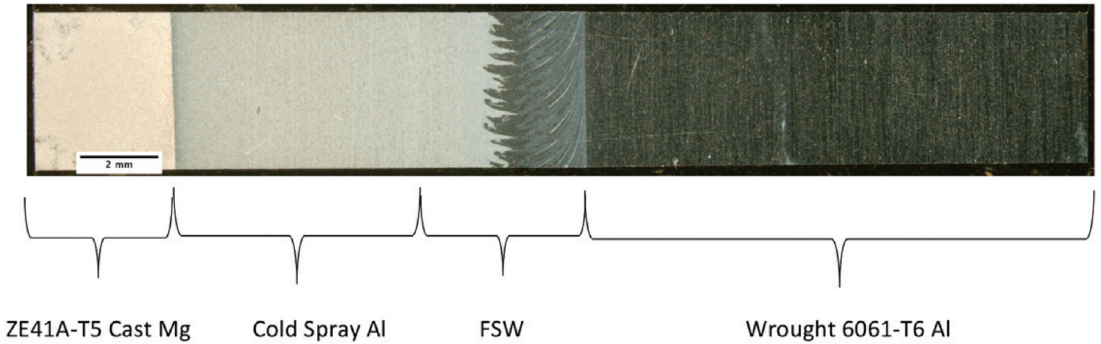
Figure 24. Photograph of the ZE41A ‐ T5 cast Mg, the cold spray Al transition layer, the friction stir weld, and the 6061 ‐ T6 wrought aluminum [62].